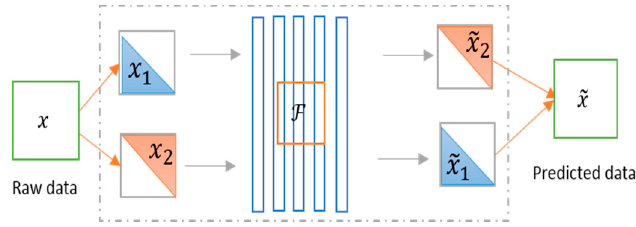
Figure 36. Split-Brain Autoencoder.